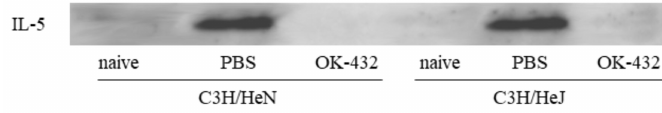
Figure 6. Eosinophil infiltration in nasal mucosae in a murine model of C3H/HeN or C3H/HeJ mice systemically sensitized with OVA and receiving subsequent intranasal challenge of OVA. Naive mice underwent no systemic sensitization. PBS-treated mice were i.p. injected with PBS on day 0 and day 7. OK-432-treated mice were i.p. injected with 100 mg OK-432 on day 0 and day 7. Data were obtained and expressed as the mean of triplicate determinations ± SD. Per experimental group, five mice were used. *, p < 0.005.